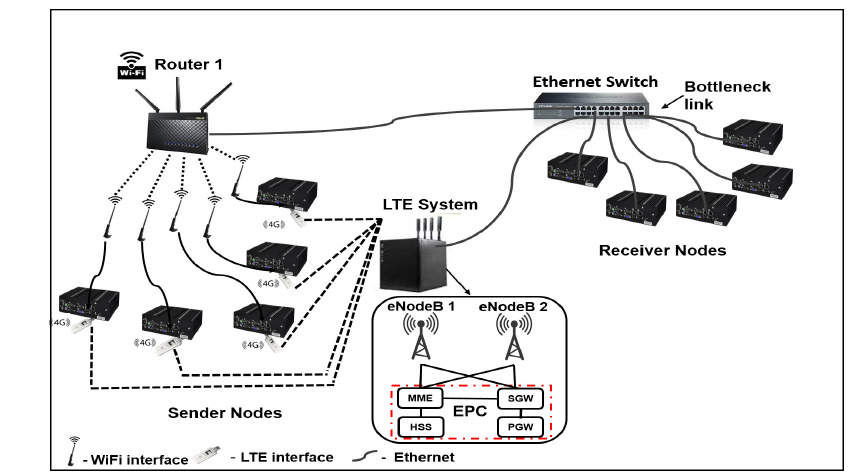
Figure 2. Testbed Setup